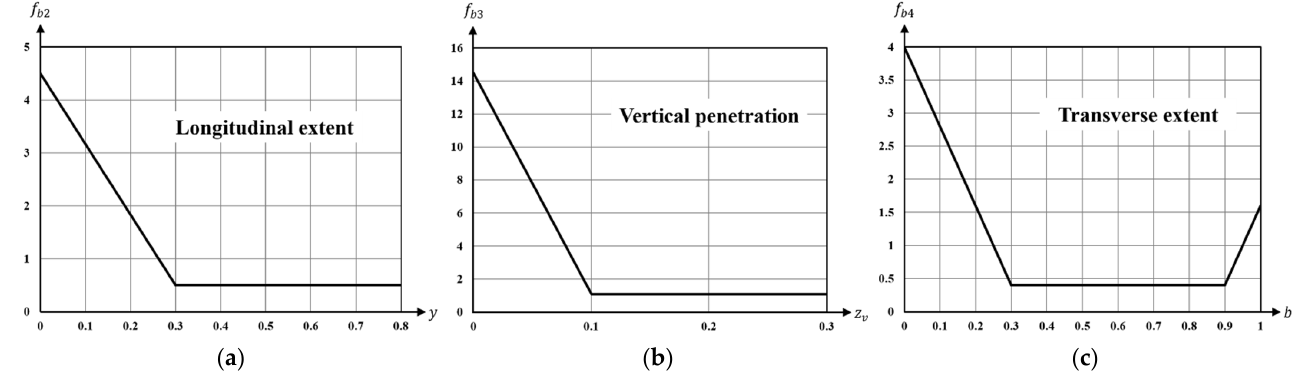
Figure 7. Bottom damage due to stranding: ( a ) density distribution functions of longitudinal extent, ( b ) density distribution functions of vertical penetration, and ( c ) density distribution functions of transverse extent.